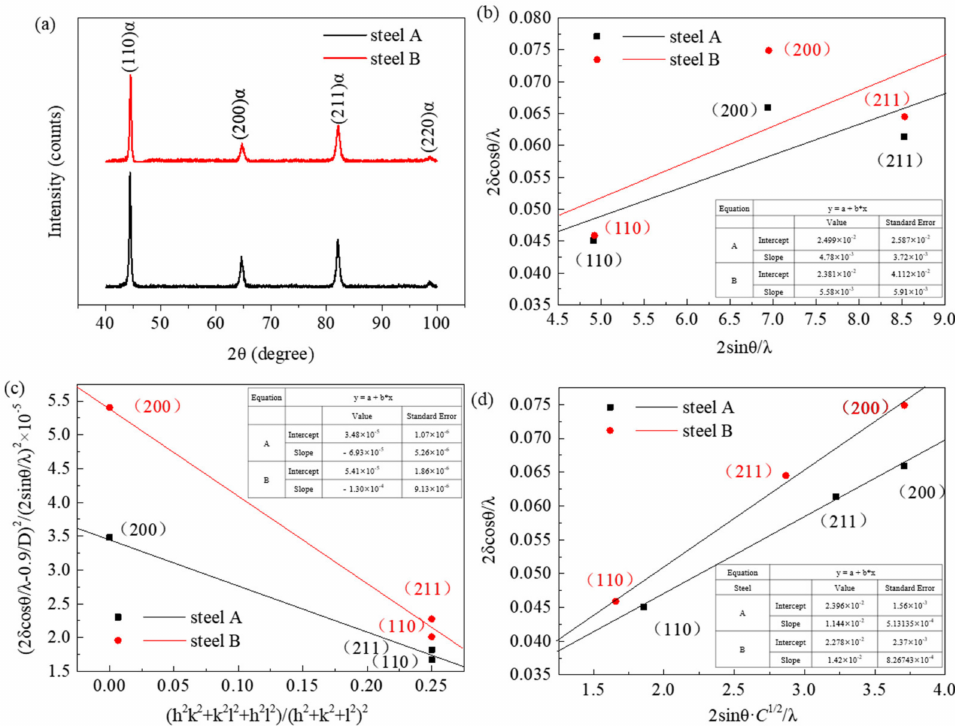
Figure 9. ( a ) The measured XRD profiles, and the estimation of dislocation density for steel A and B heated to 880 ◦ C then air cooling according to a linear relationship between 2sin θ / λ and 2 δ cos θ / λ 2 δ cos θ / λ ( d ). Table 3. Chemical composition of the matrix (wt%) of steel A, B and the calculated σ s . Samples